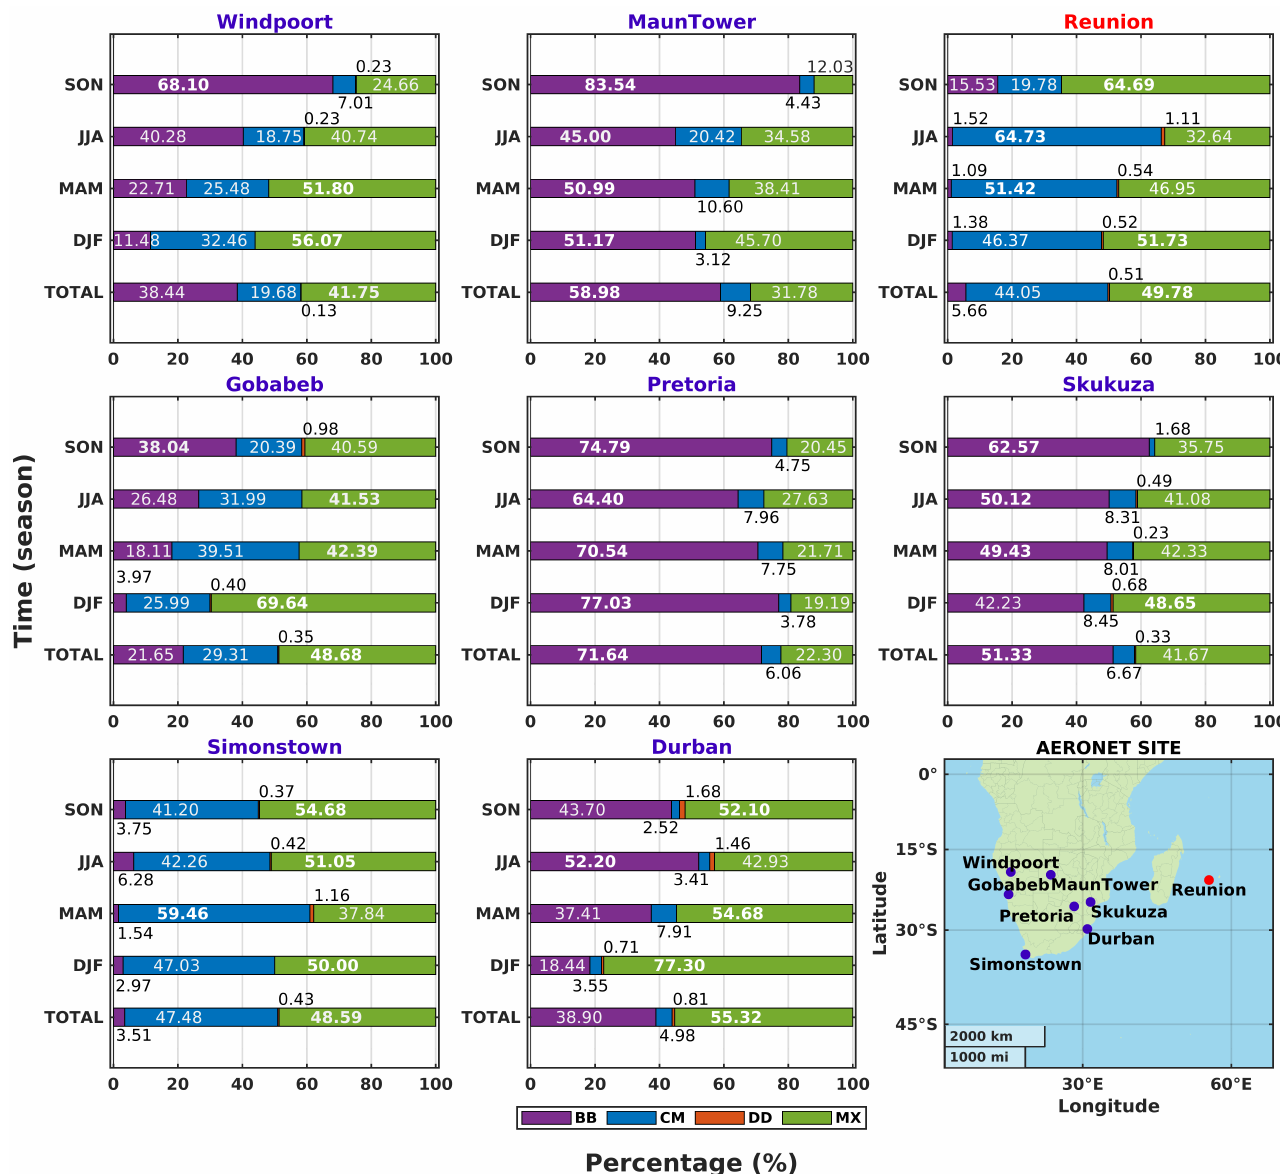
Figure 7. Aerosol classification from sun photometer data over the eight sun photometer sites. The multiyear seasonal and annual (referred to as “TOTAL”) relative occurrence frequency as a percentage. Each type is associated with one color: clean marine (CM) in blue, biomass burning/urban industrial (BB/UR) in purple, desert dust (DD) in orange, and mixed type (MX) in green. Examining the aerosol optical properties and aerosol types reveals the highest AOD val- ues and highest frequencies of the BB/UR aerosol type for some sites in spring and